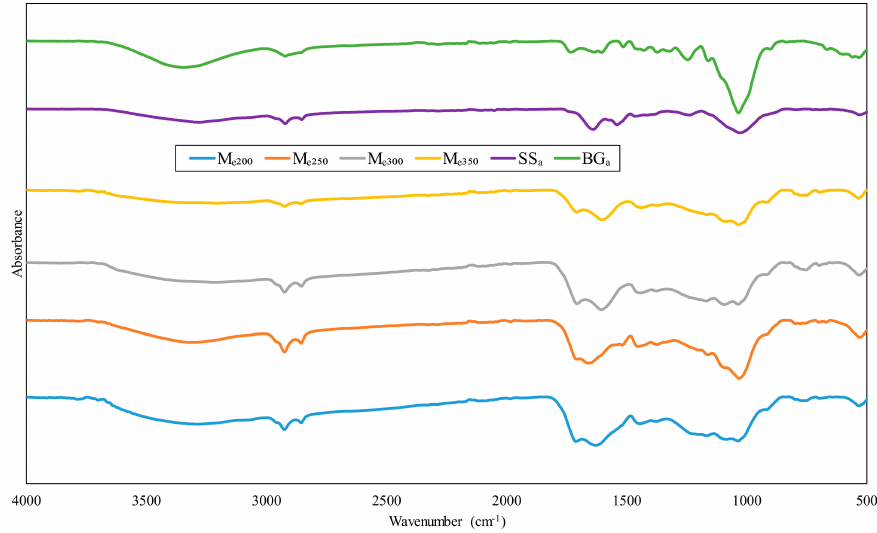
Figure 6. IR spectra for 50:50 mixing ratio of torrefied sewage sludge and sugarcane